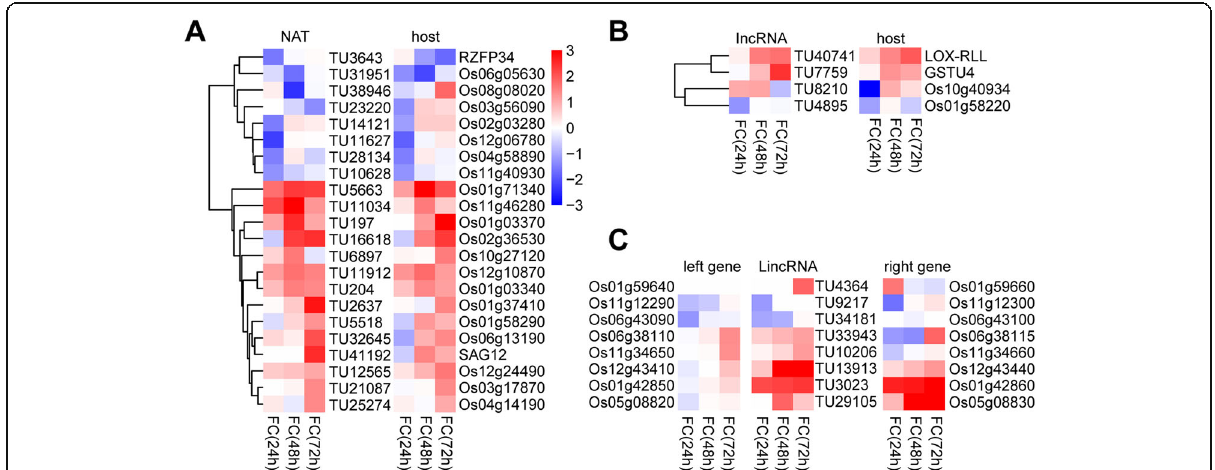
Fig. 3 Expression pattern of blast fungus-responsive LncRNAs and their host or neighboring genes. Heatmap representing the transcript abundance fold change (FC) of NAT ( a ), IncRNA ( b ) and their host gene in M. oryzae -treated samples compared with control samples ( c ). Heatmap representing the transcript abundance fold change of LincRNA and its neighboring gene in M. oryzae -treated samples compared with control samples. U, up-regulated; D, down-regulated